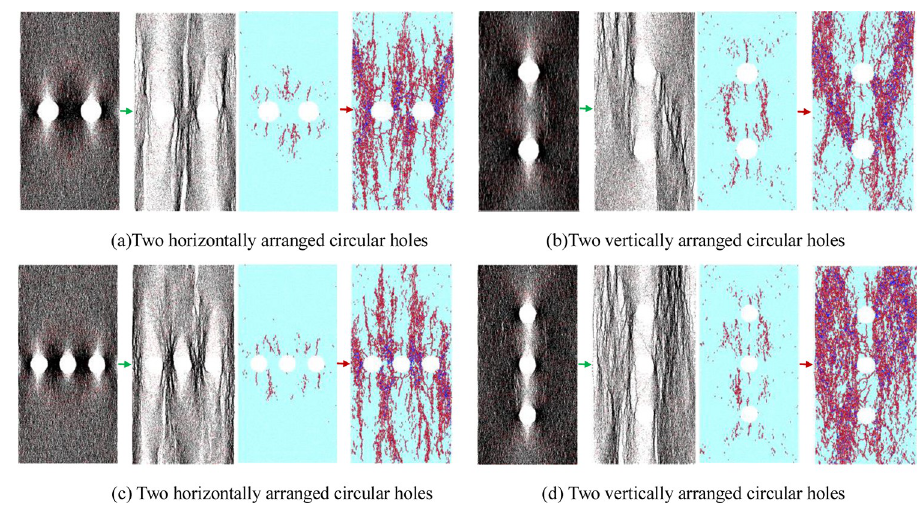
Fig 13. Contact force chain and crack evolution characteristics of the models with two and three circular holes. (a) Two horizontally arranged circular holes, (b) Two vertically arranged circular holes, (c) Two horizontally arranged circular holes, (d) Two vertically arranged circular